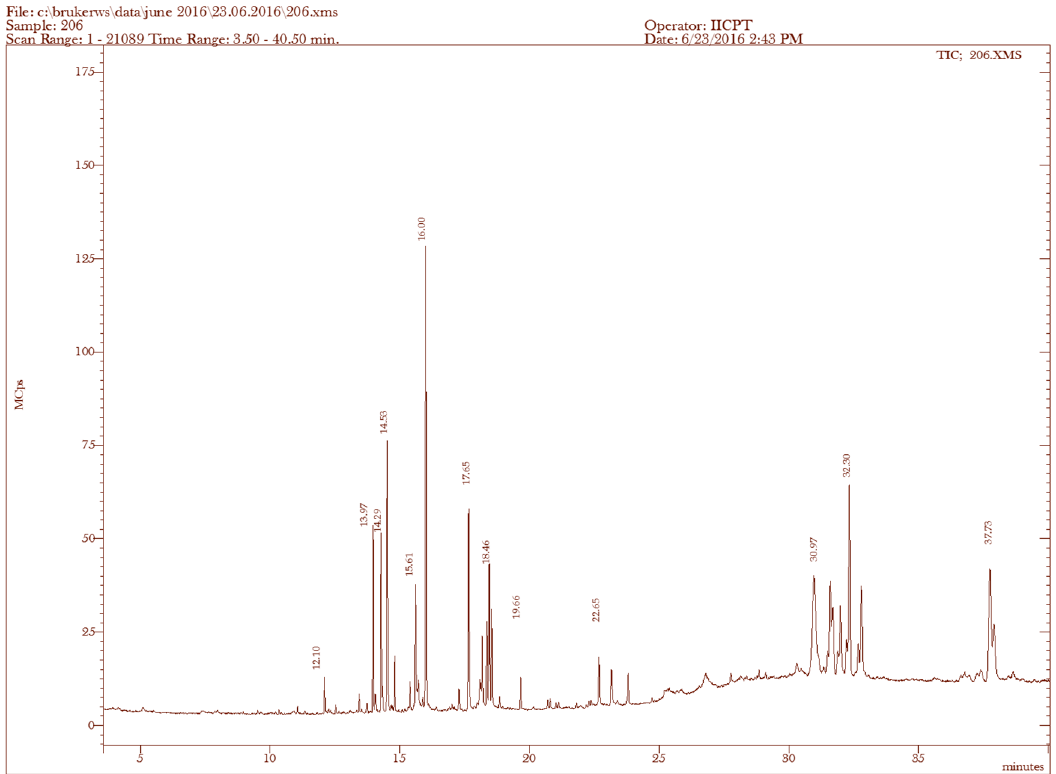
Figure 3. GC–MS/MS chromatogram formed by ethanolic fractions of Ulva prolifera . The 436-GC Bruker model coupled with a triple quadrupole mass spectrometer was used to study the chemical composition of the ethanolic fractions of the two plants. The MS Workstation 8 and the library database of National Institute Standard and Technology (NIST Version 11.0) were used for the identification of the chemical components. Table 3. Bioactive compounds identified in ethanolic fractions of L. paniculata by GC–MS/MS analysis.